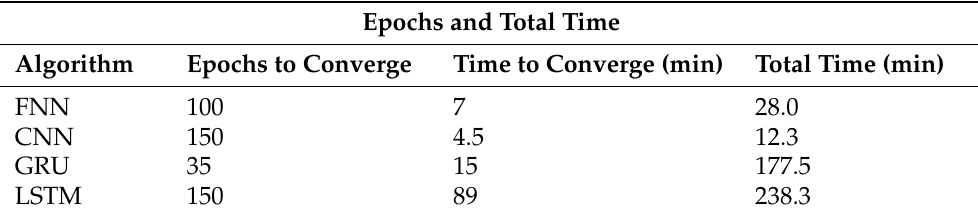
Table 3. Performance comparison of the